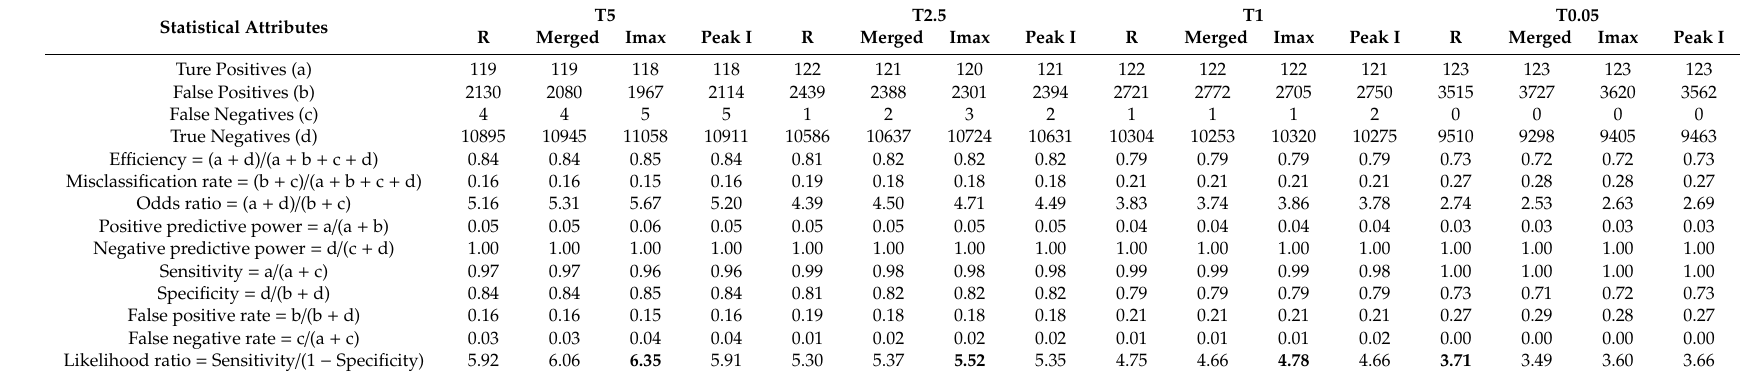
Table 1. Statistical Comparison of the derived thresholds. (The maximum likelihood ratio values are highlighted in bold.). Statistical